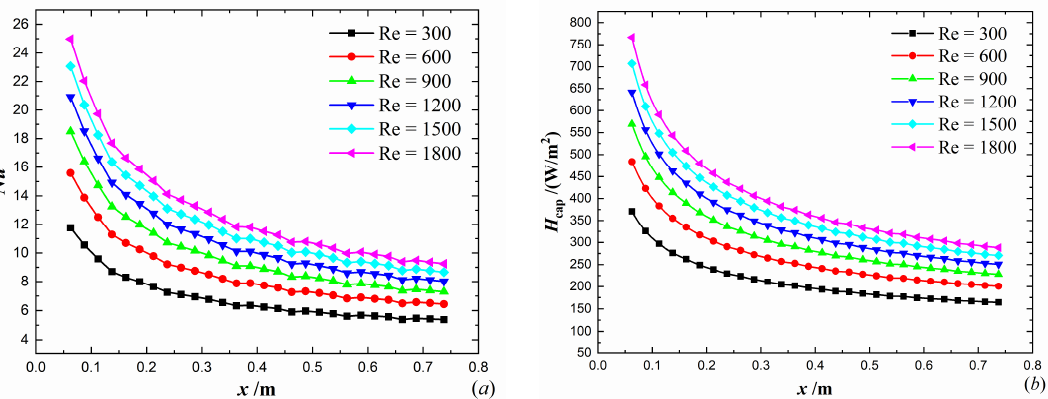
Figure 8. The variation of Nusselt number ( a ) and heat convection intensity ( b ) along the tube under the constant heat flux boundary.